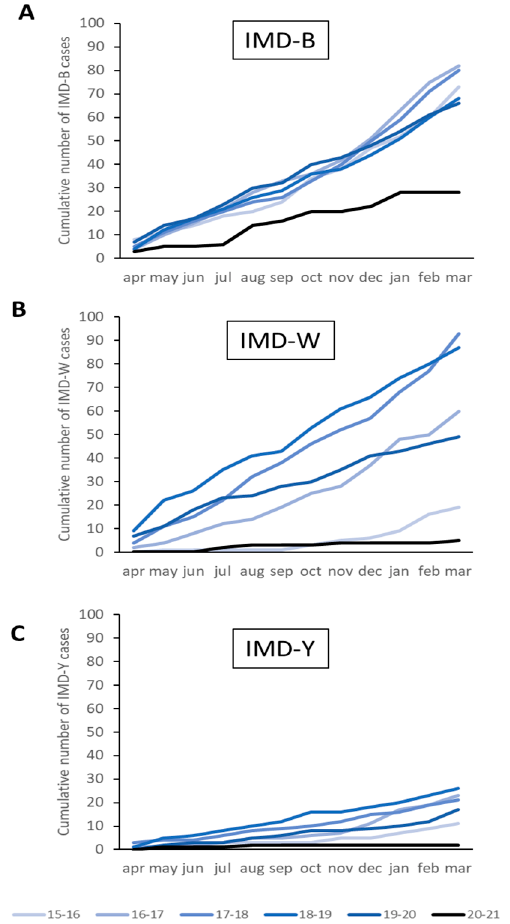
Figure 2. Cumulative number of cases of invasive meningococcal disease caused by ( A ): serogroup B; ( B ): serogroup W; and ( C ): serogroup Y in the first COVID-19 year (2020–2021; black) compared to the previous five pre-COVID-19 years (blue).